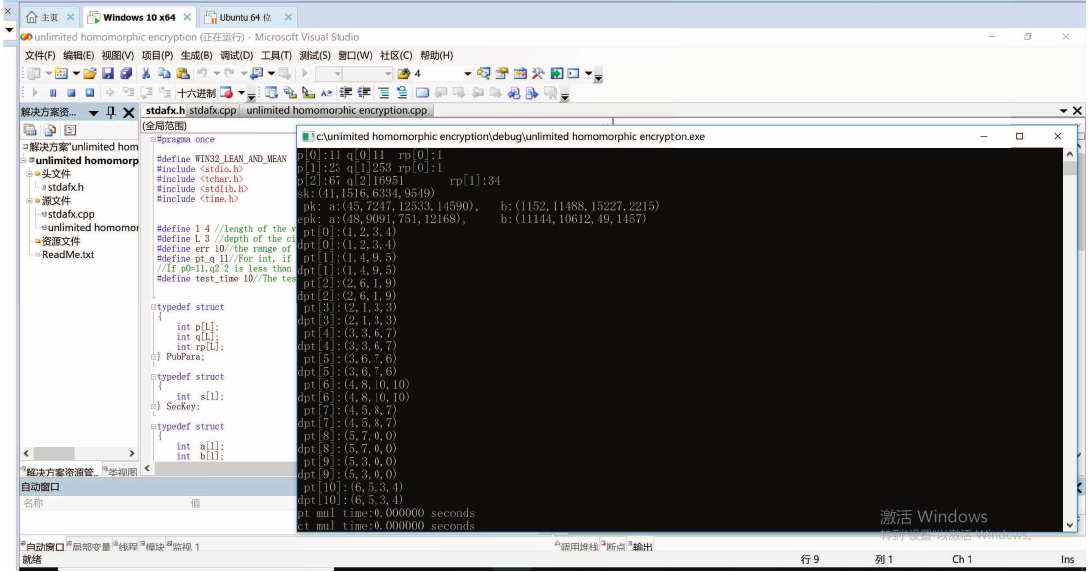
Figure 1. Example of five Multiplications and five Additions.